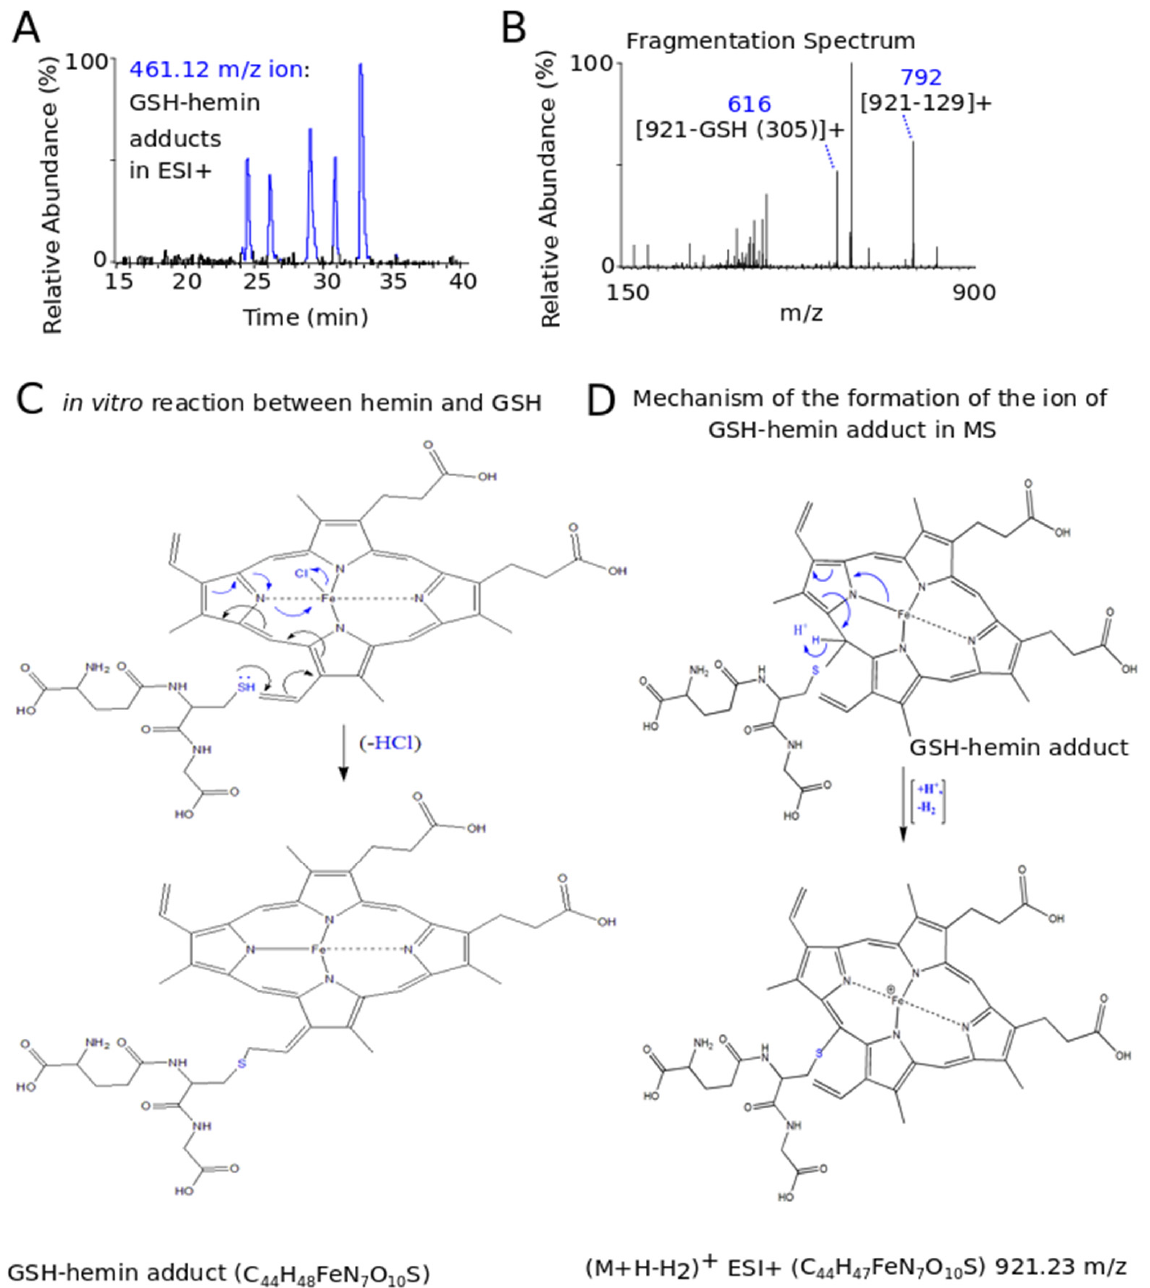
Figure 4. GSH–hemin adducts were uncovered as the products in the in vitro reaction between GSH and hemin. Hemin (50 μΜ ) was incubated with GSH (2 mM) at 37 °C for 120 min. Thereafter, the reaction products were full-spectrum (200–2000) m/z analyzed in LC-MS, and the gained data files